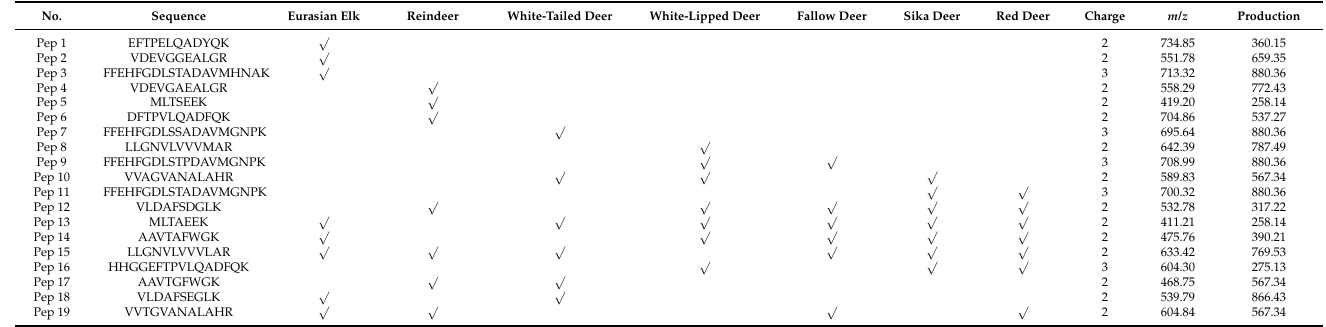
Table 1. Sequences of peptide biomarkers and their specificity (positive ion